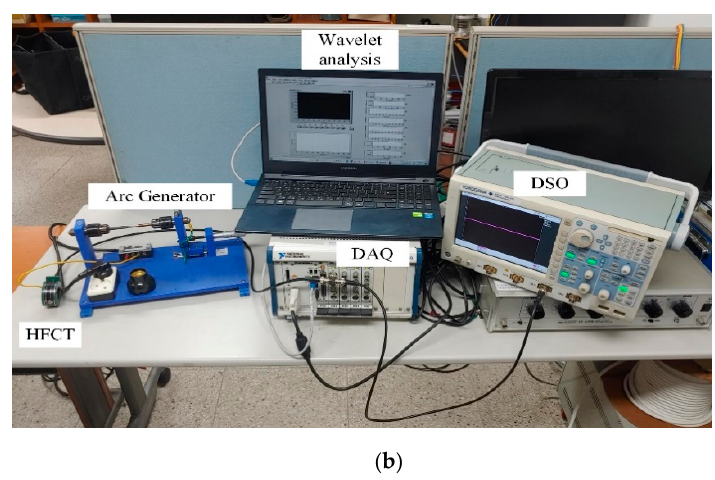
Figure 8. Experimental setup. ( a ) circuit; ( b ) photograph.